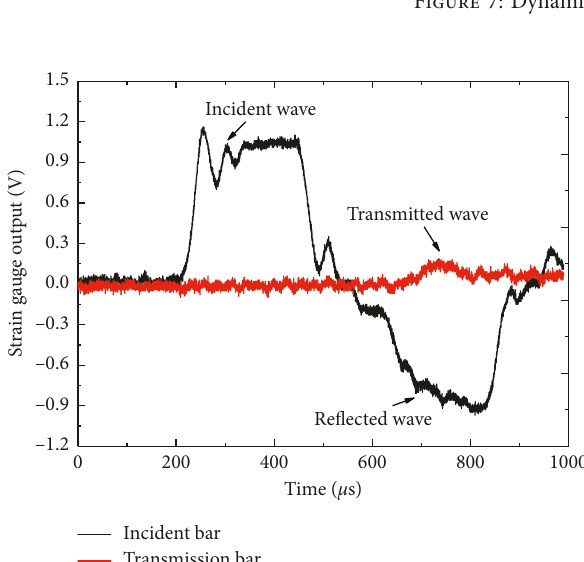
Figure 8: Three-wave time-history diagram of the SHPB dynamic Brazilian disc test.